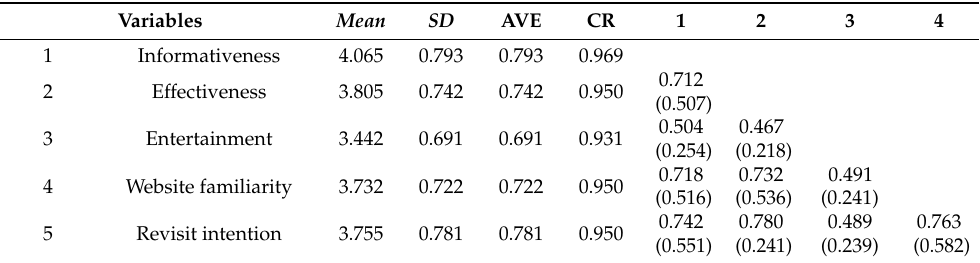
Table 3. Descriptive statistics and correlation matrix.